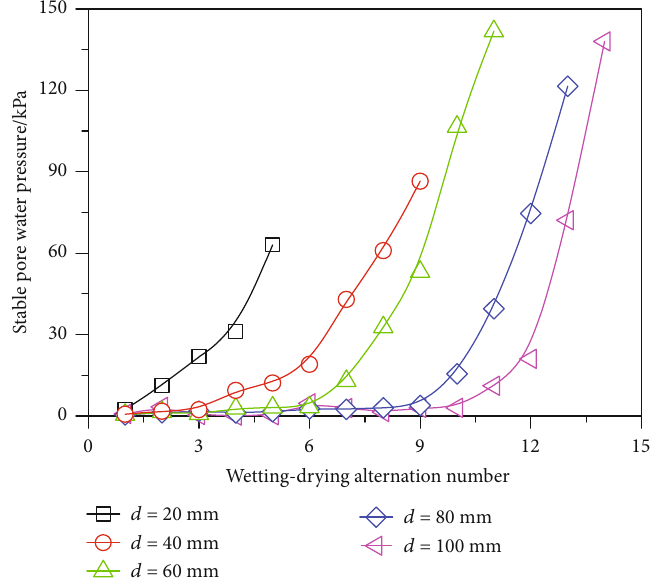
Figure 5: Variation in stable water pressure with the increase of wetting-drying alternation